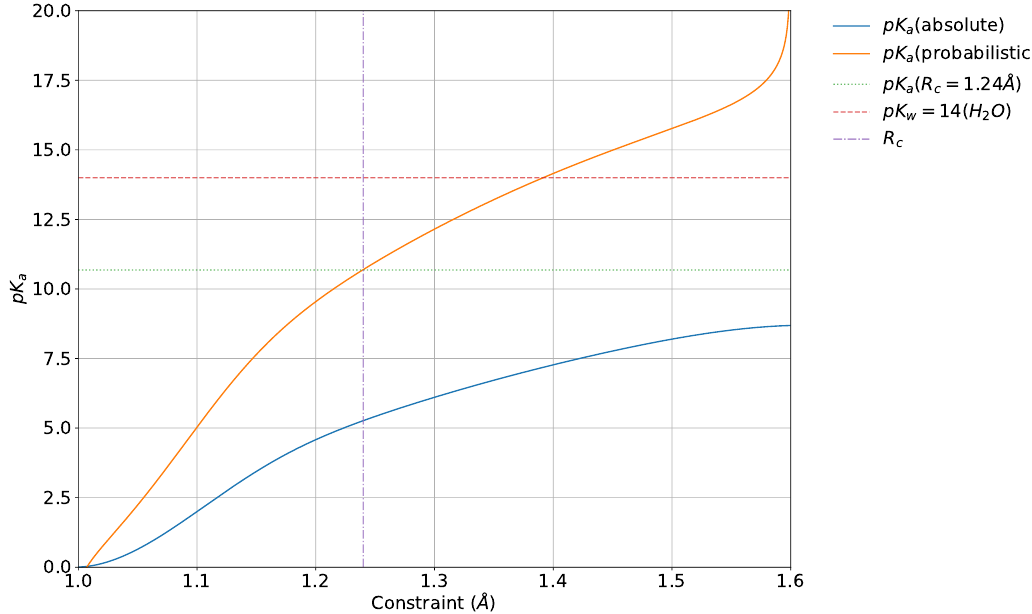
Figure 6. p K a values calculated for PhOH using the absolute and probabilistic method. The latter is strongly dependent on the choice of R c , even a change by 0.01 Å might result in change of up to 0.5 p K a